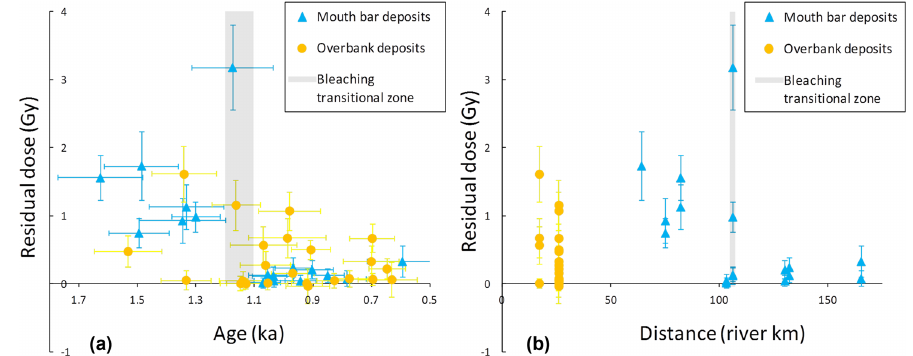
Figure 6. Bleaching of sands isolated from mouth bar and overbank deposits with (a) burial age obtained using the bootMAM OSL approach; (b) distance seaward in river kilometers relative to the junction of the modern river channel and Bayou Lafourche. The shaded region indicates the transition zone from heterogeneously to well-bleached mouth bar deposits circa 1.2–1.1ka, or around 100 river kilometers seaward of the junction.